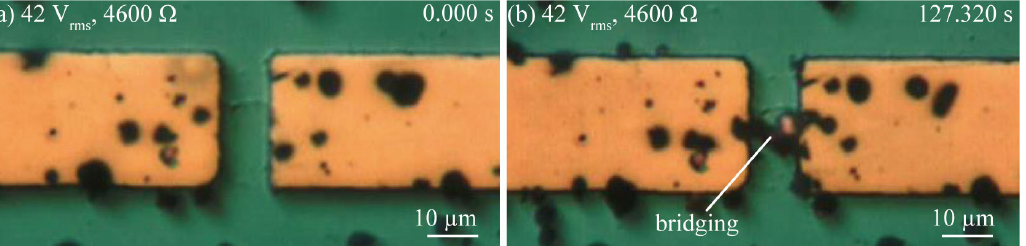
Figure 5. Series of optical images showing copper microparticle chain formation in the case of a high voltage with low reference value of current (42 V rms , 4600 Ω ). ( a ) The beginning of the application of voltage to the gap. ( b ) Microparticles being trapped in the gap, thereby bridging the gap.